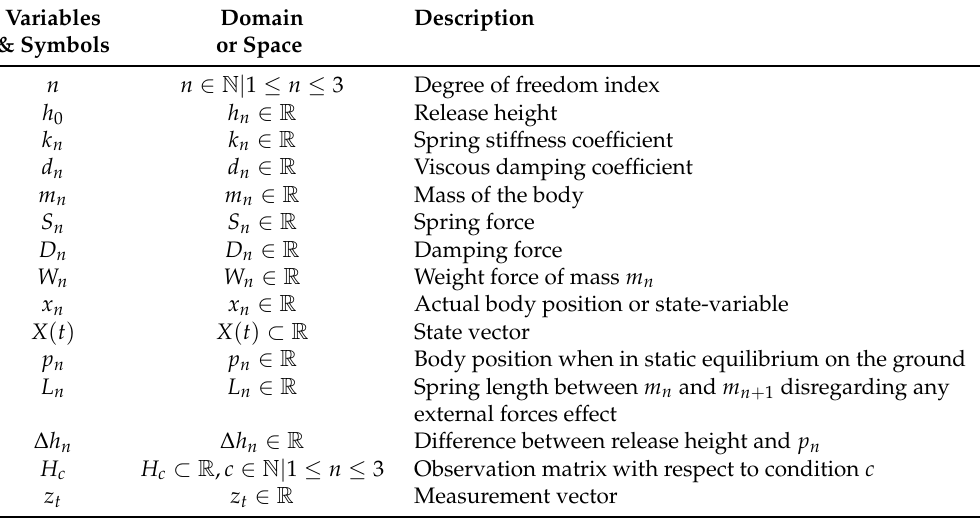
Table 6. Parameters and variables of the Physical Model.